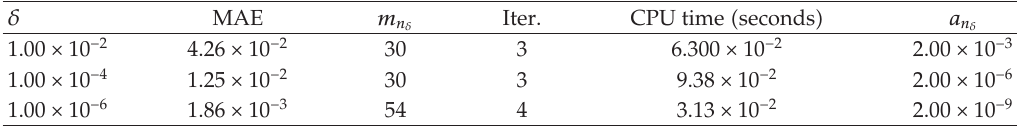
Table 5: Example